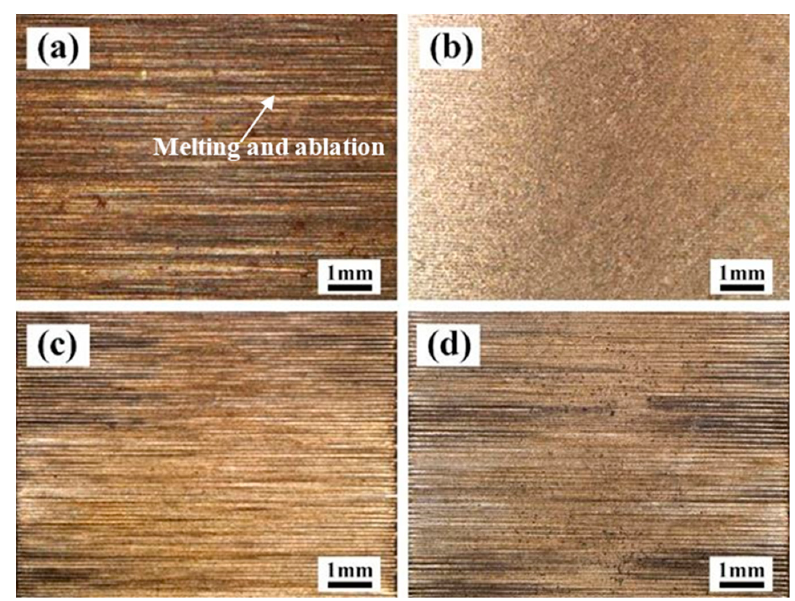
Figure 5. The effect of laser Y-moving speed on the macro morphology of the cleaned surface. ( a ) 5 mm/s; ( b ) 7 mm/s; ( c ) 9 mm/s; ( d ) 11 mm/s at X-scanning speed of 1500 mm/s.